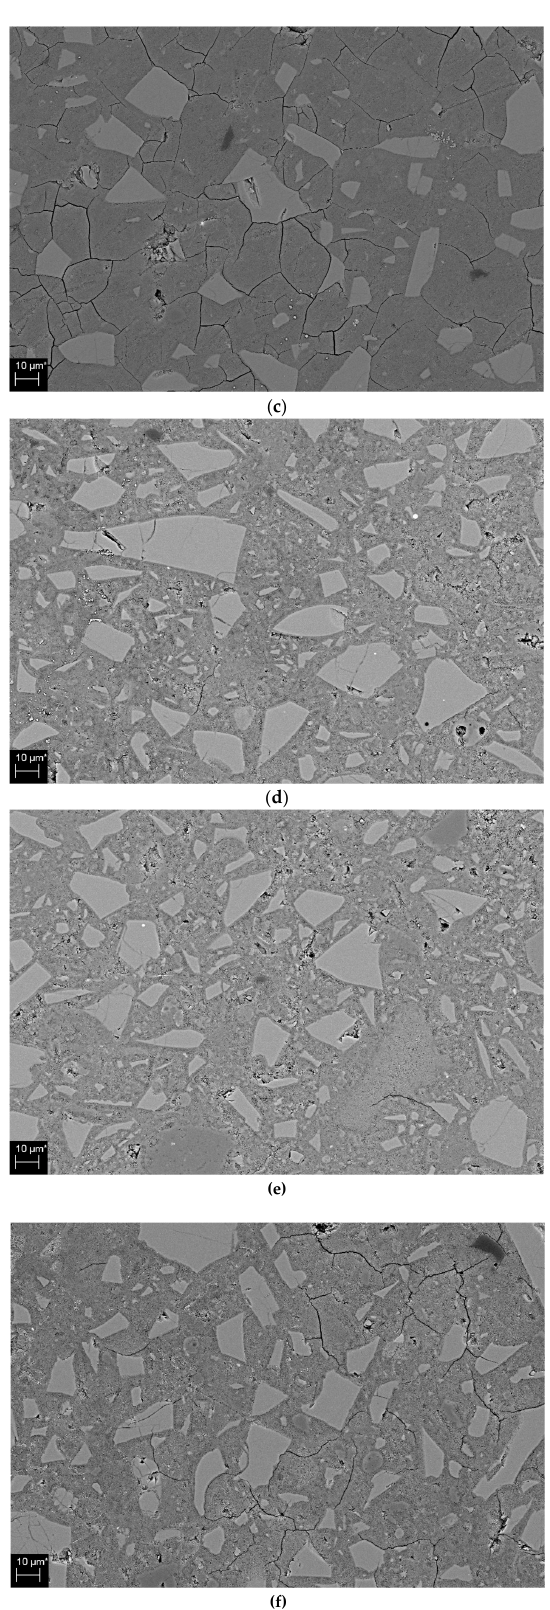
Figure 9. SEM/BSE image of hydration products: ( a ) 5% activator, 0% CNS, ( b ) 5% activator, 20% CNS, ( c ) 5% activator, 50% CNS, ( d ) 10% activator, 0% CNS, ( e ) 10% activator, 20% CNS, ( f ) 10% activator, 50% CNS.